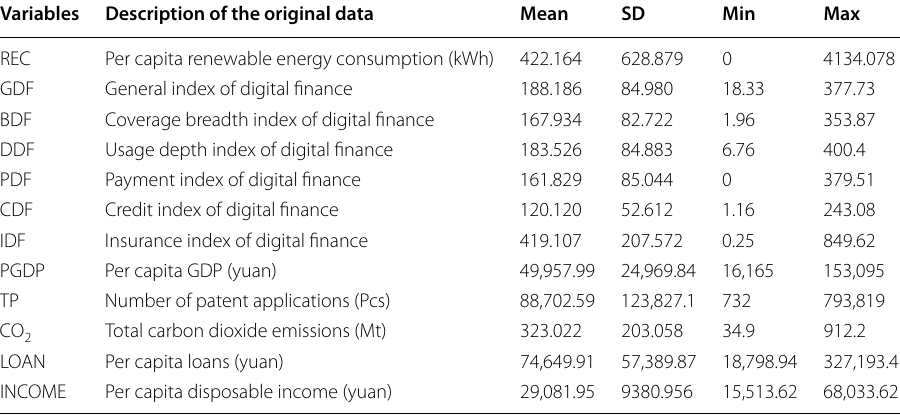
Table 1 Summary